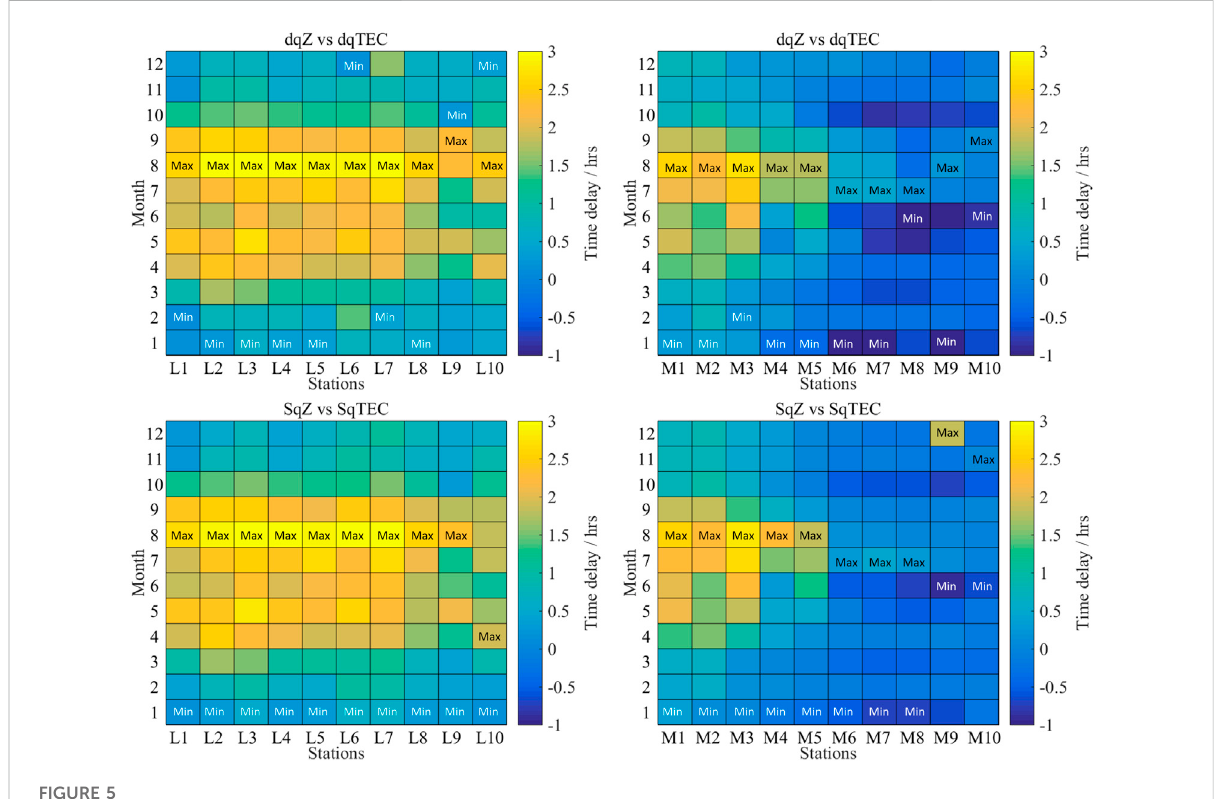
FIGURE 5 Comparison of average time delay in different